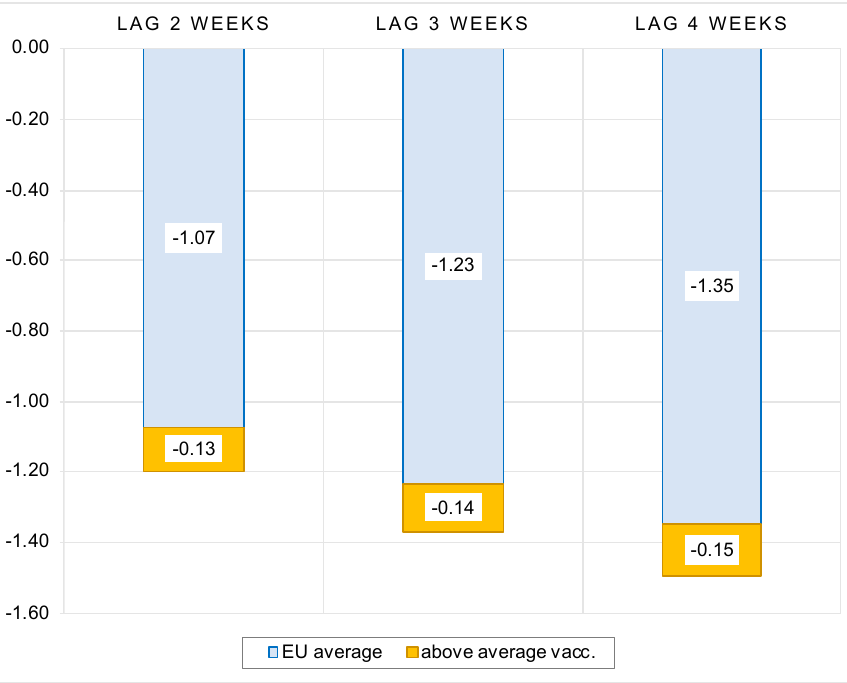
Figure 3. Impact of vaccination rate on number of new COVID cases, sample of EU countries. Notes: Figure contains the estimated elasticities of the per-million number of new COVID cases to the vaccination rate obtained by estimating the model (1). See Table A3 in the Appendix for the full results.